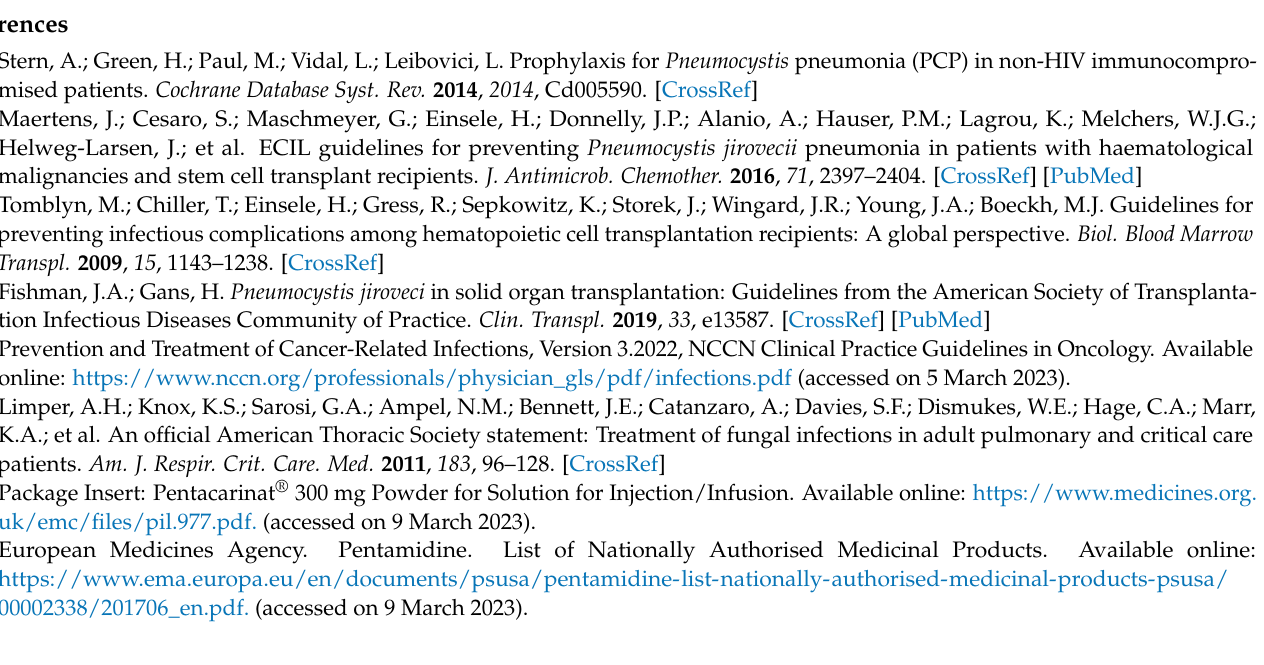
Table S3: Excluded studies and reasons; Table S4: Modified risk of bias tool developed By Hoy et al. and Edward et al; Table S5: Risk of bias analysis for all studies included in the review; Table S6: Sensitivity analysis and subgroup analysis of breakthrough PCP in patients who received intravenous pentamidine; Table S7: Meta-regression of breakthrough PCP in patients who received intravenous pentamidine; Table S8: Sensitivity analysis and subgroup analysis of incidence of adverse reaction in patients who received intravenous pentamidine; Table S9: Meta-regression of incidence of adverse reaction in patients who received intravenous pentamidine; Table S10: Sensitivity analysis and subgroup analysis of adverse event-related discontinuation in patients received intravenous pentamidine; Table S11: Meta-regression of adverse event-related discontinuation in patients received intravenous